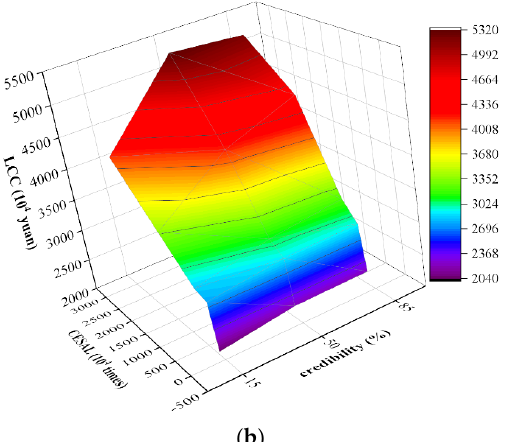
Figure 7. The LCC of the EA system and the GA system under representative traffic conditions and